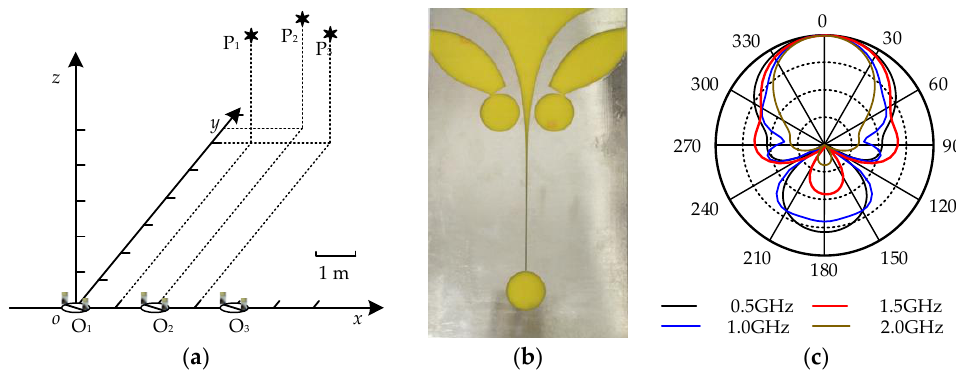
Figure 4. The simulation model arrangement and the Vivaldi antenna; ( a ) The space distribution of the simulated PD sources and the measurement points; ( b ) The Vivaldi antenna; ( c ) The radiation pattern of the Vivaldi antenna. Table 1. The parameters of the three simulated PD sources.